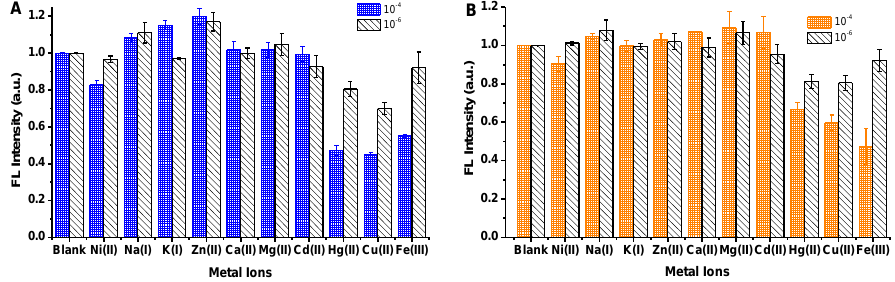
Figure 5. Effect of metal ions on the fluorescence (FL) intensity of the polysaccharide-based NSs prepared from starch ( A ) and chitosan ( B